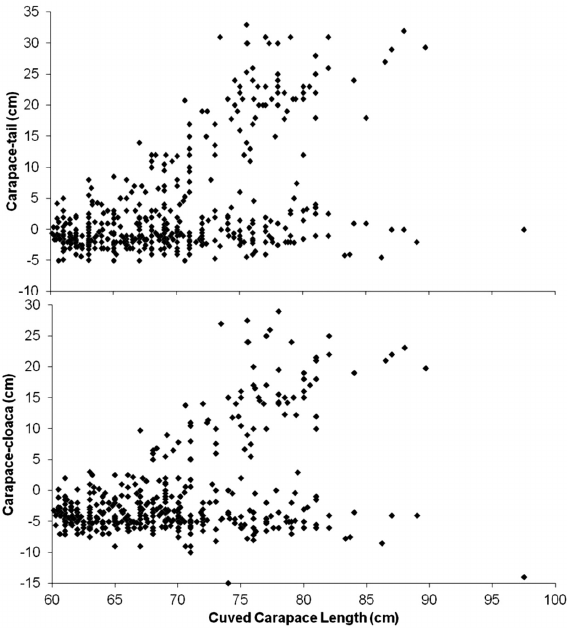
Fig. 2. – Distribution according to curved carapace length of two measures of the tail (carapace-tail and carapace-cloaca) of 460 log- gerhead sea turtles from the Tunisian shelf, central